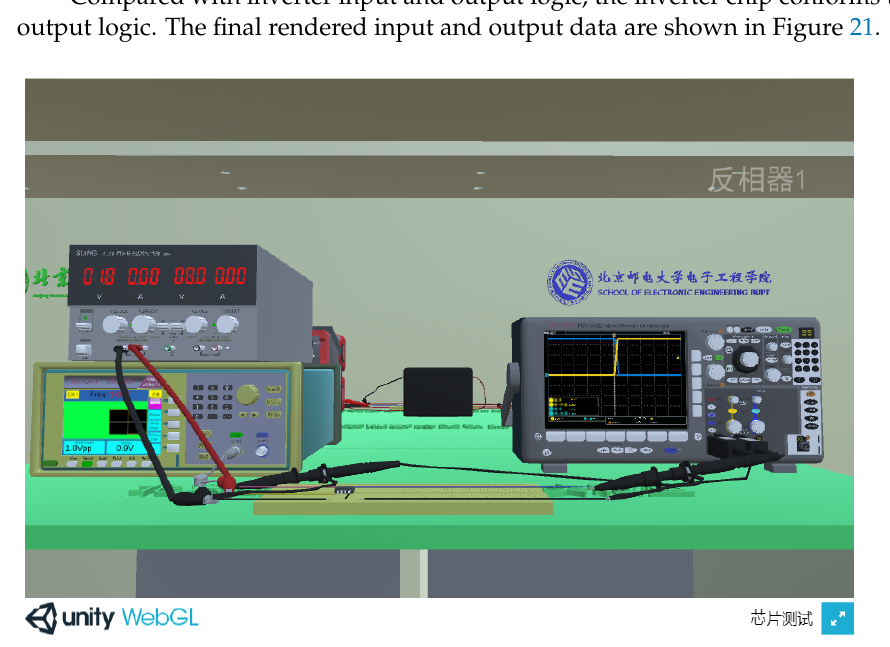
Figure 20. The result is a piece of inverter in a Dip8 package.